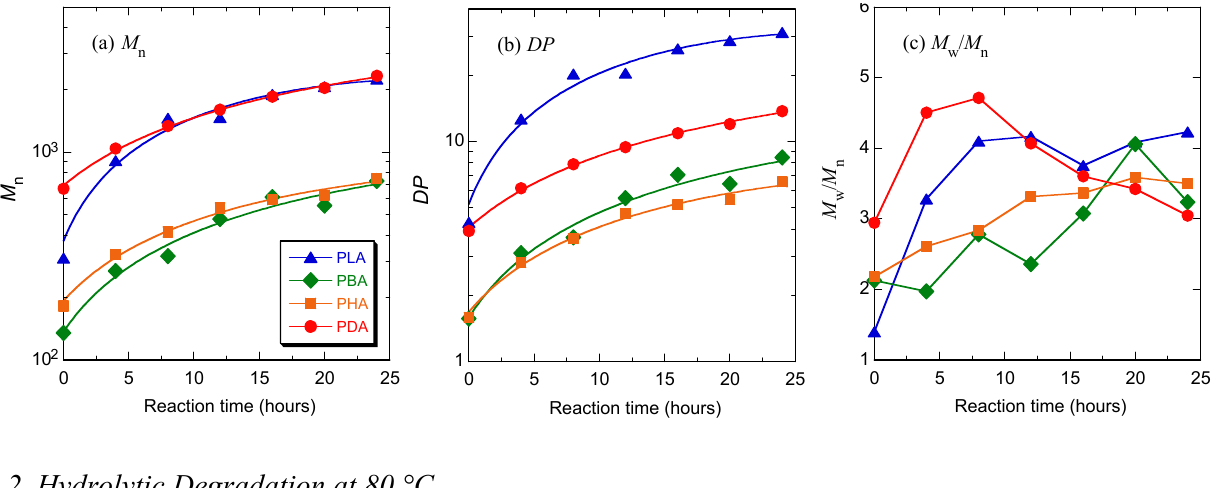
Figure 3. M ( a ), DP estimated from M n ( c ) of PLA, PBA, PHA, and PDA during the second polymerization step under reduced pressure at different times, as a function of reaction time.